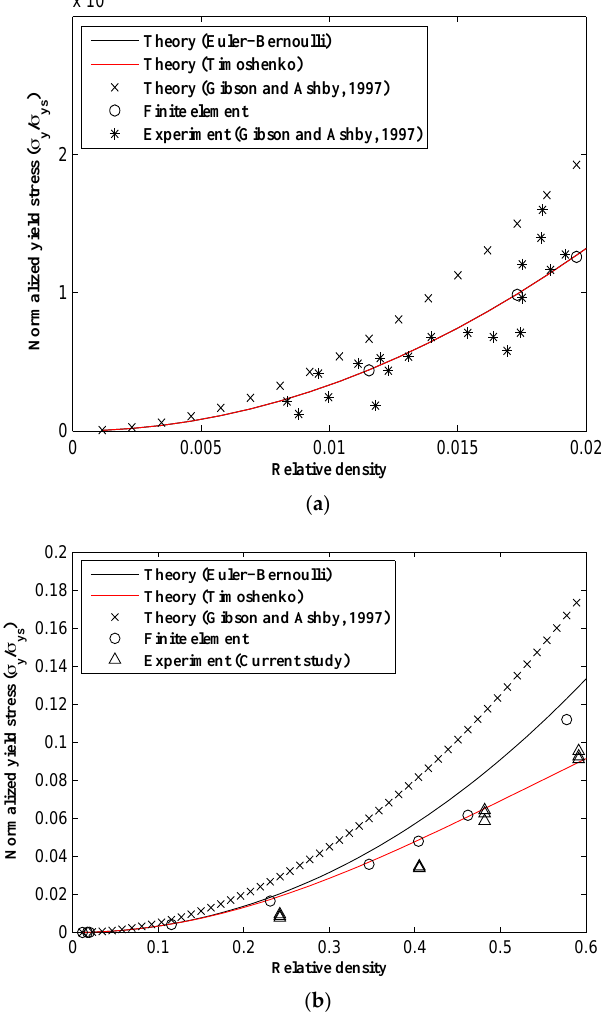
` ˘ vs. relative density ( (cid:2025)/(cid:2025) (cid:3046) ) for (cid:2869) σ y { σ ys vs. relative density ( ρ { ρ s ) for 1